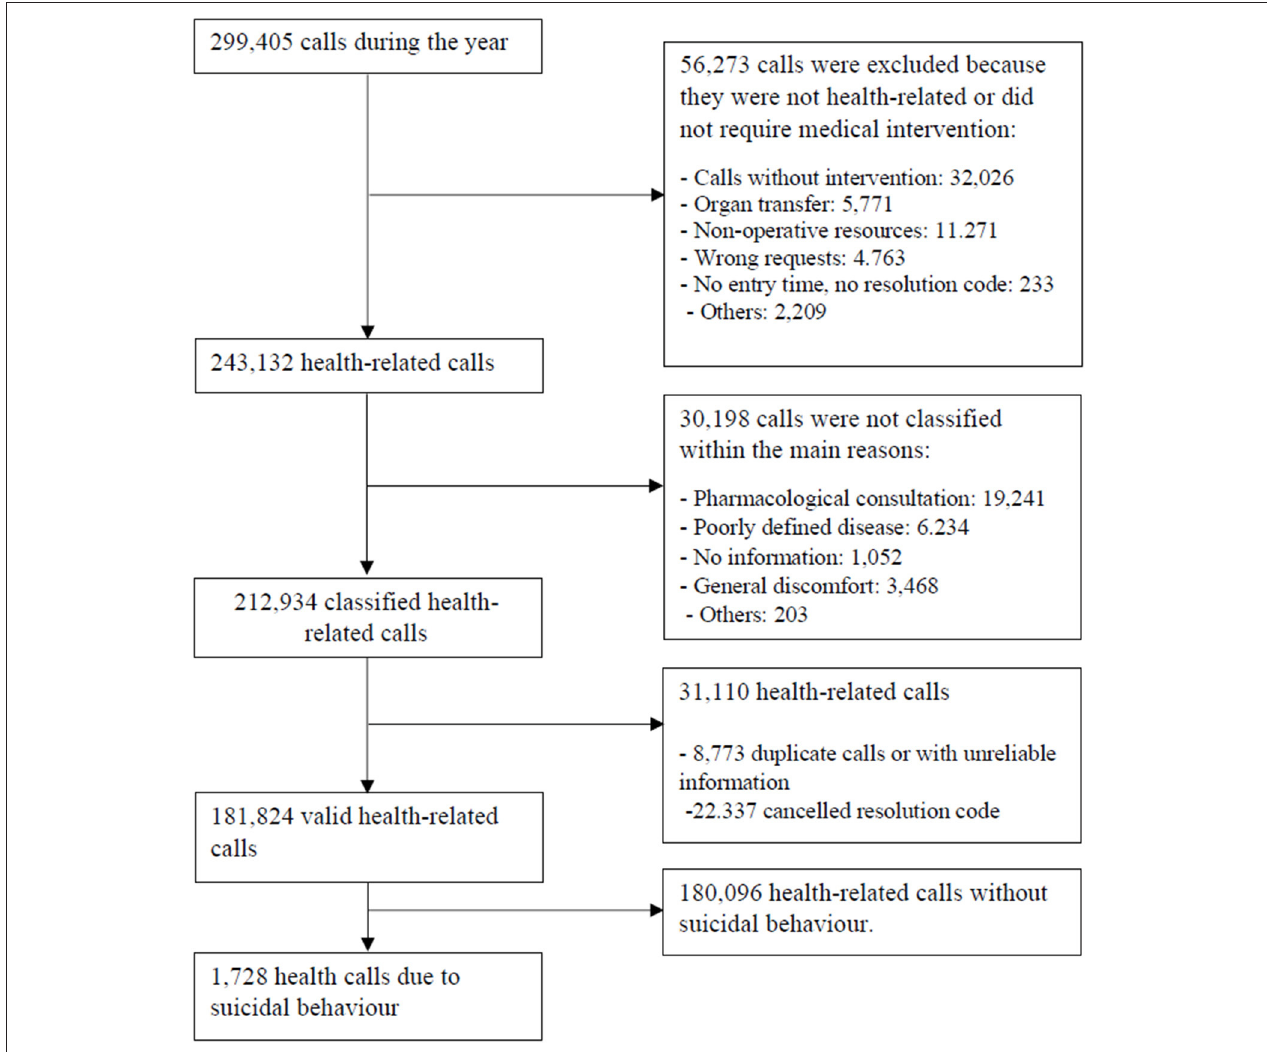
FIGURE 1 | Flow chart of the study sample selection